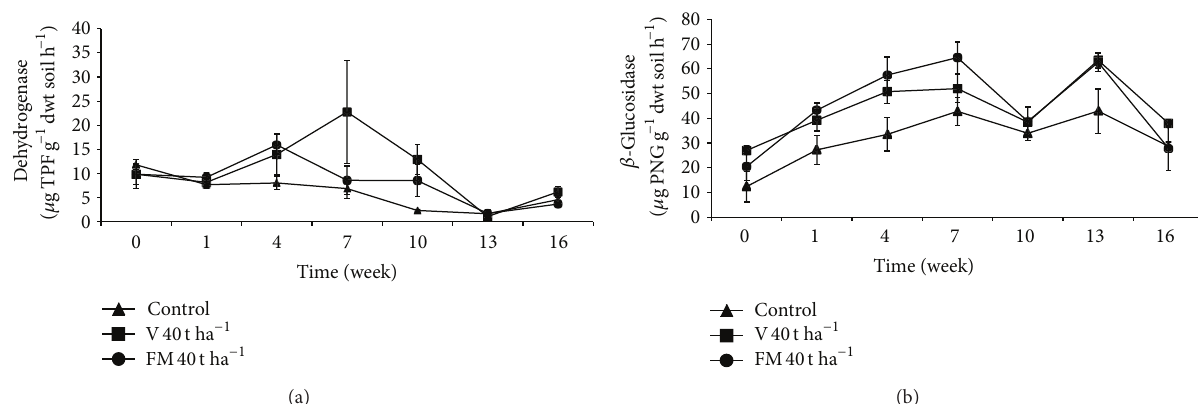
Figure 2: Changes in dehydrogenase (a) and 𝛽 -glucosidase (b) activity in soils treated with vermicompost (V) and farmyard manure (FM) at the rate of 40tha −1 . Error bars represent standard errors based on four